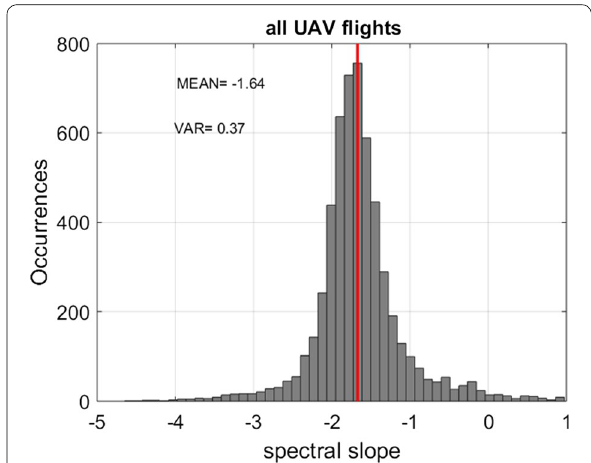
Fig. 5 Histogram of slopes of relative speed spectra calculated in the 1.0–7.5 Hz band for all ShUREX 2016 UAV